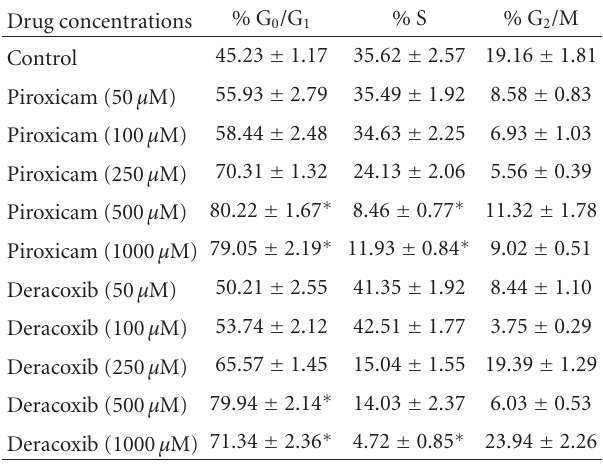
Table 1: E ff ects of piroxicam and deracoxib on cell cycle phase distribution of CMT-U27 cells. Data are expressed as mean values ± standard error of means shown with ∗ P < 0 . 05 versus control